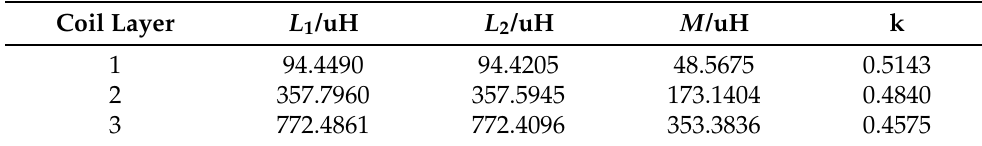
Table 2. Mutual inductance under different coil layer.